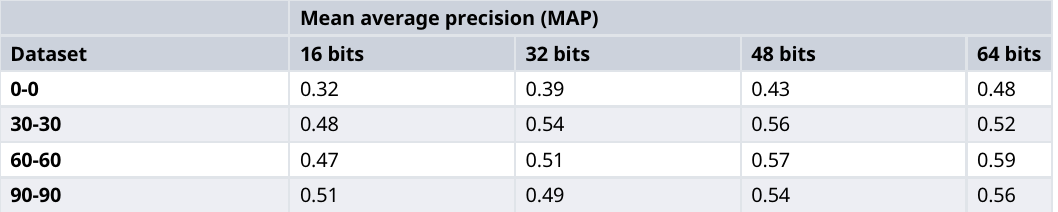
Table 4. MAP for the OUISIR- MVLP dataset in the same-condition